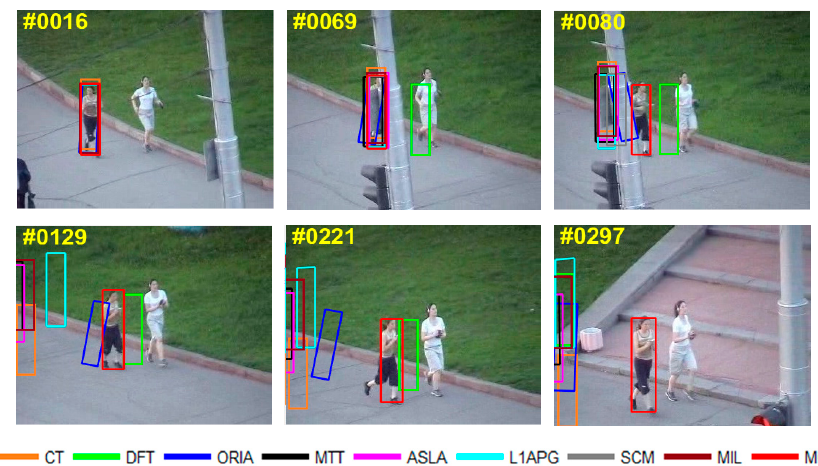
Figure 11. Tracking results on Jogging-1 .